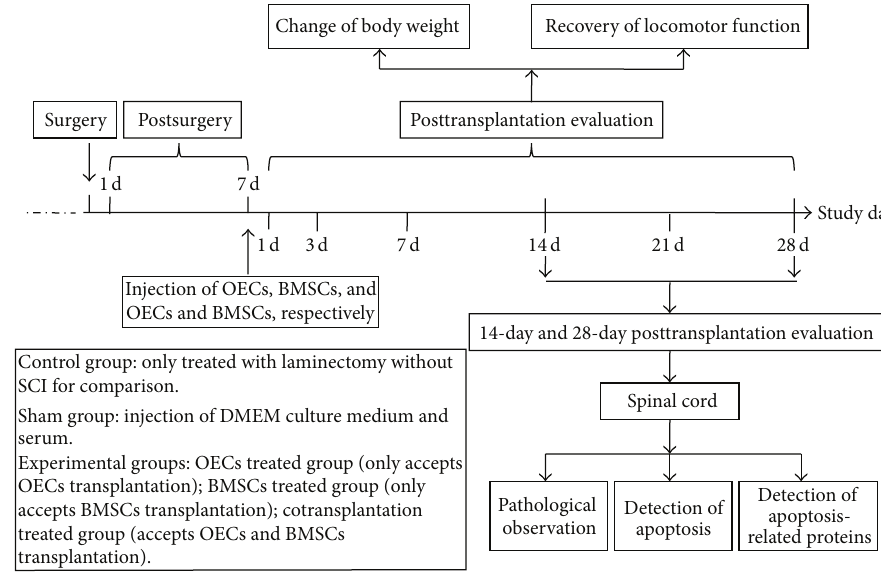
Figure 1: Animal experimental design of antiapoptotic effects of cotransplantation of OECs and BMSCs in adult rats.